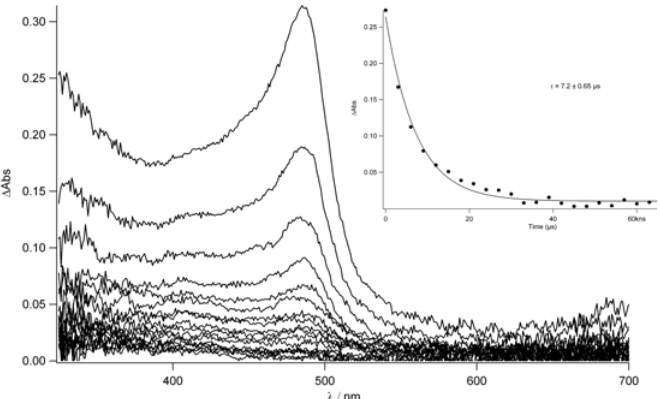
Figure 10. Nanosecond transient absorption spectrum of TpyTol in acetonitrile with = 290 nm and 2 µs increment.  ex